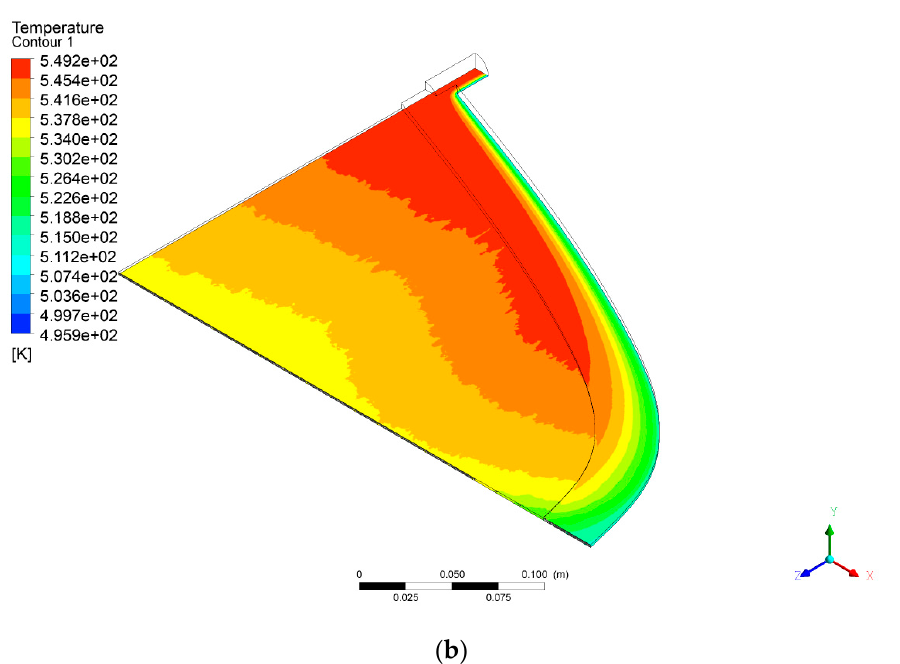
Figure 10. Temperature distribution for ( a ) the initial die and ( b ) optimized die.